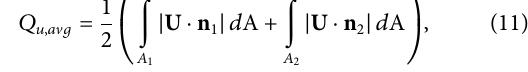
FIGURE 5 | Non-dimensional velocity pro fi le along the center line predicted using the coarse, base and fi ne meshes.